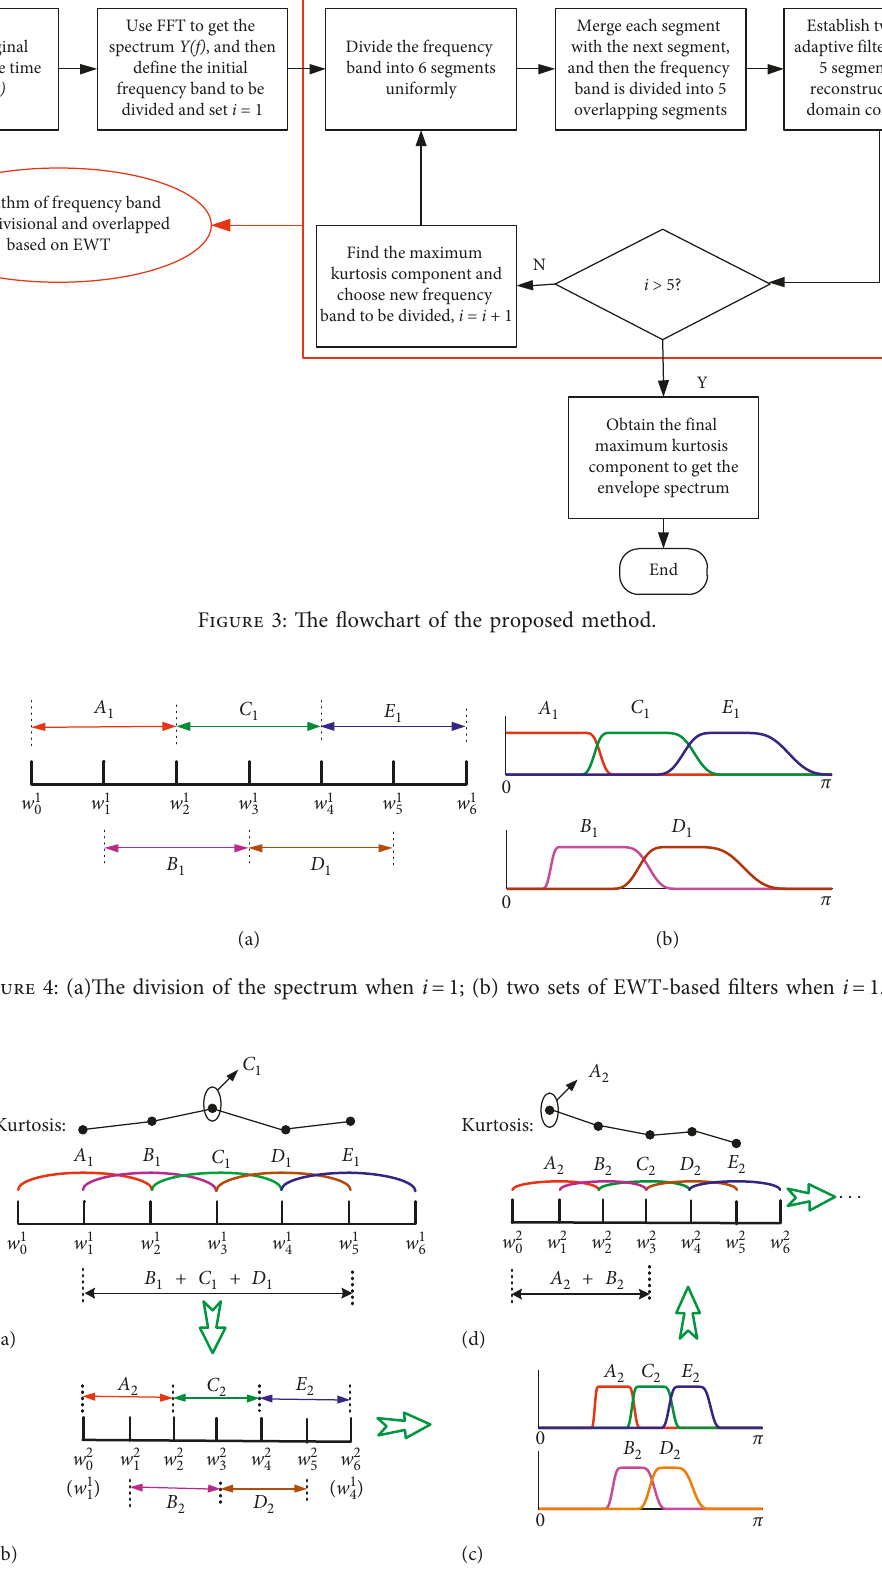
Figure 5: (a)Kurtosis polyline graph and new frequency band to be divided; (b) the division of the spectrum when i � 2; (c) two sets of EWT- based filters when i � 2; (d)kurtosis polyline graph and new frequency band to be divided in the next